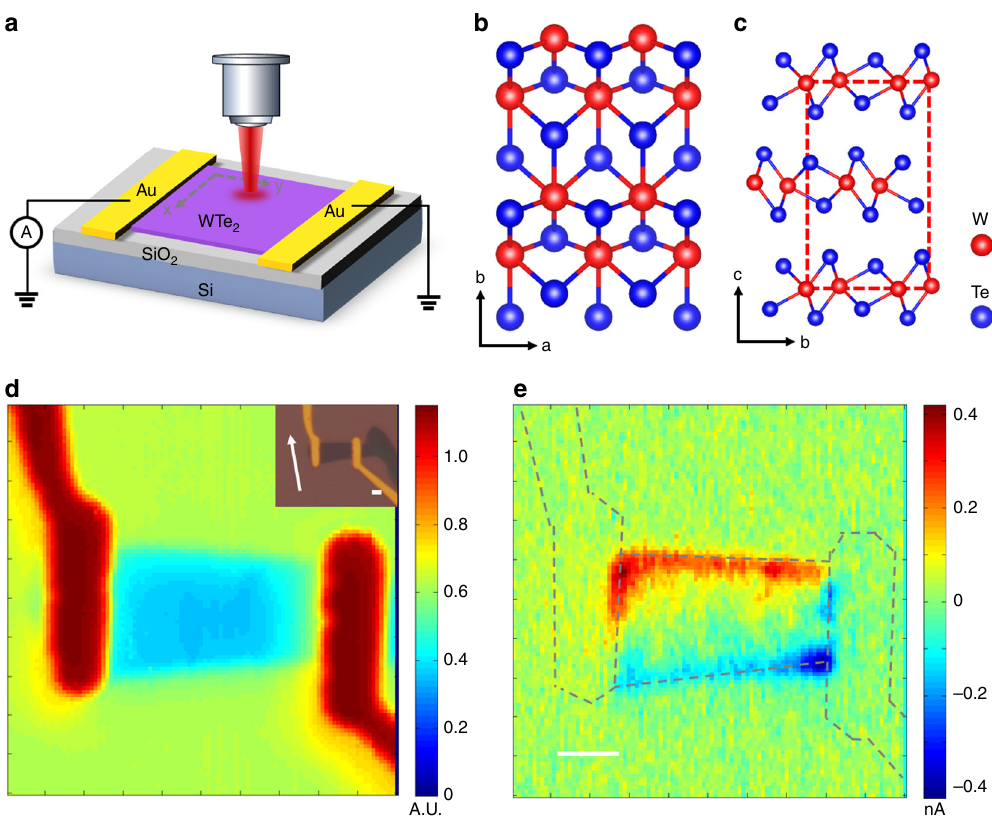
Fig. 1 Edge photocurrent response in WTe 2 . a Schematic diagram of scanning photocurrent measurement of a WTe 2 fi eld effect device. b , c Crystal structure of WTe 2 . Top view of the crystal structure of ^ a (cid:1) ^ b plane ( b ) and cross-section view of the interlayer stacking structure ( c ) of T d- WTe 2 . d , e Scanning re fl ection image ( d ) and scanning photocurrent response ( e ) of a typical 6-nm thick WTe 2 device. The measurement was performed with 633-nm light fi ltered from white light super-continuum and the power shine on the sample was about 15 μ W. The excitation light was focused using a 100× objective lens and the focused spot size was 0.85 μ m. The inset of Figure e is the optical microscope image and the white arrow marks the crystallographic ^ a -axis. The scale bars are all 2 μ Fig. 2a. The device has irregular top edges with fi ve different major directions and the long bottom edge is identi fi ed to be along the <100> direction. According to the SPCM shown in Fig. 2b, we observe photocurrents along three of the fi ve edges at the top, while the other two top edges and the bottom edge show no photocurrent responses, and all these edges with vanishing photocurrent response are identi fi ed to be along the <100> direction. Furthermore, the photocurrent from the area labeled 1 on the top edge is negative, while those from the areas labelled 3 and 5 are positive. The device shown in Fig. 2c, d exhibits similar but more salient photocurrent response. The top edge along <100> has no photocurrent response, while the two bottom edges, with a fracture direction about 11-degree angle with respect to the top edge, show clear photocurrent responses.